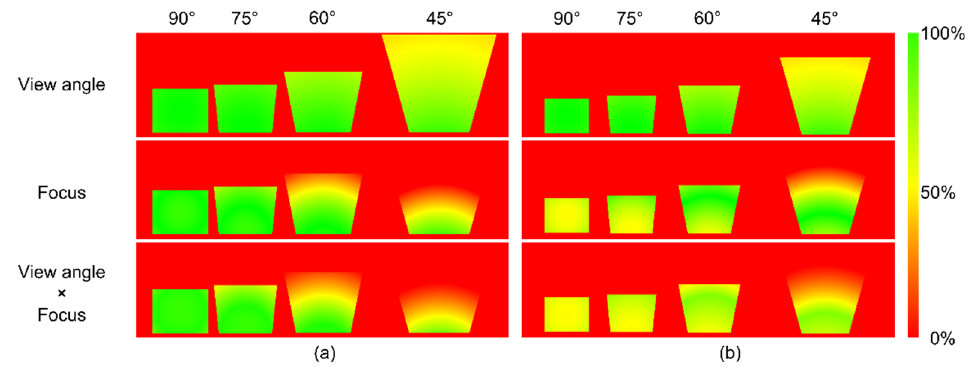
Figure 4. Visualization of the field of view on a flat surface under the impact of view angle (first row), focus (second row) and combination of both (third row) for four different camera tilt angles: ( a ) distance between camera and surface is 200 mm and ( b ) distance between camera and surface is 160 mm.